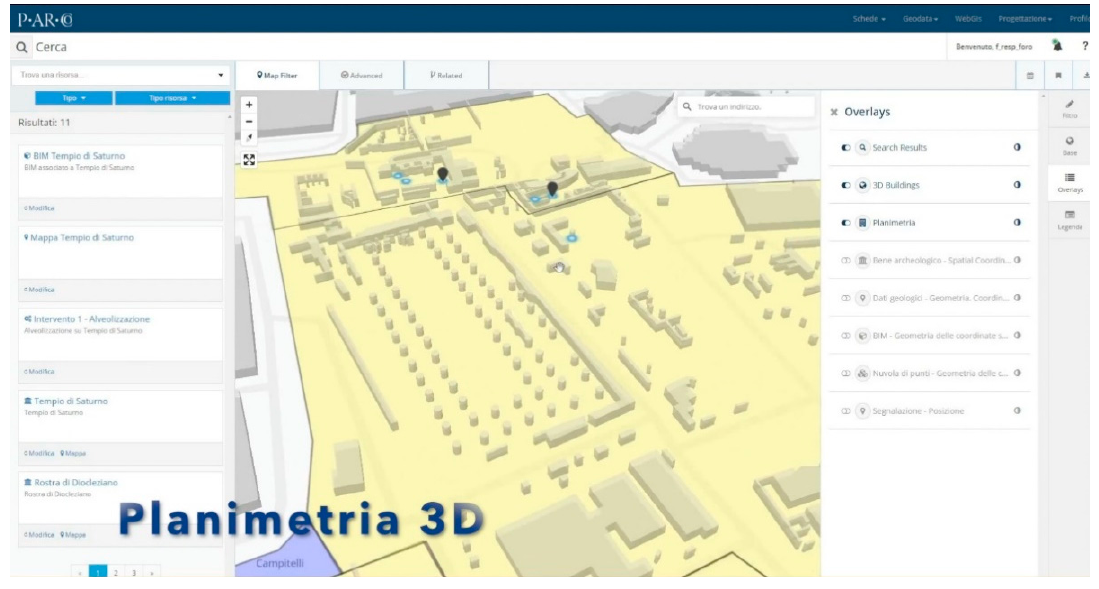
Figure 5. SyPEAH, 3D plan.